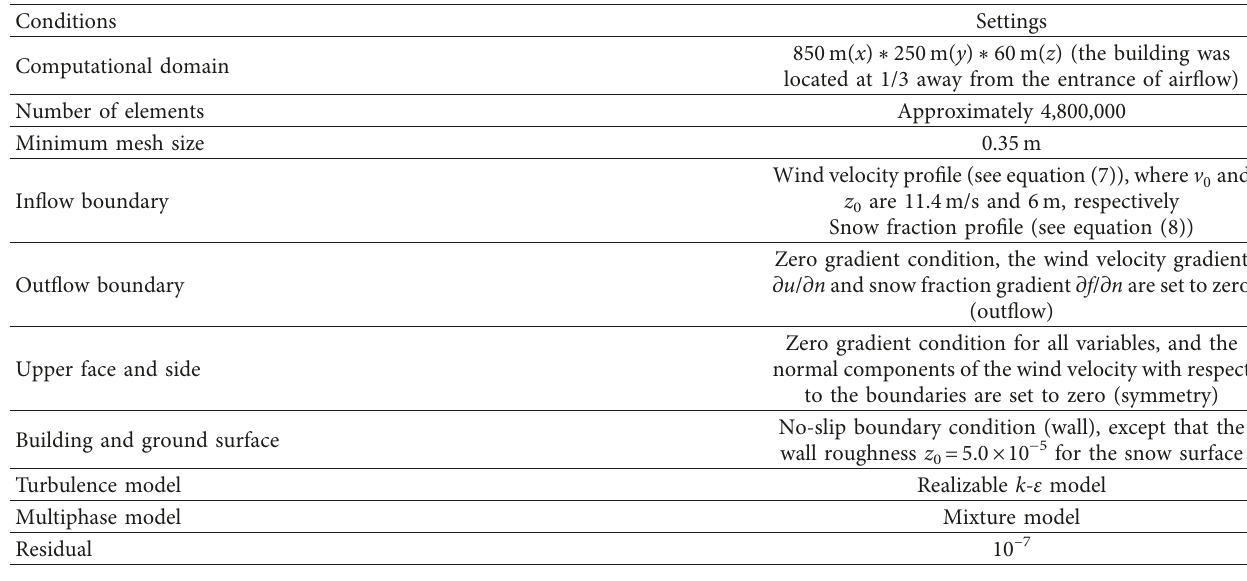
Table 6: Computation conditions.